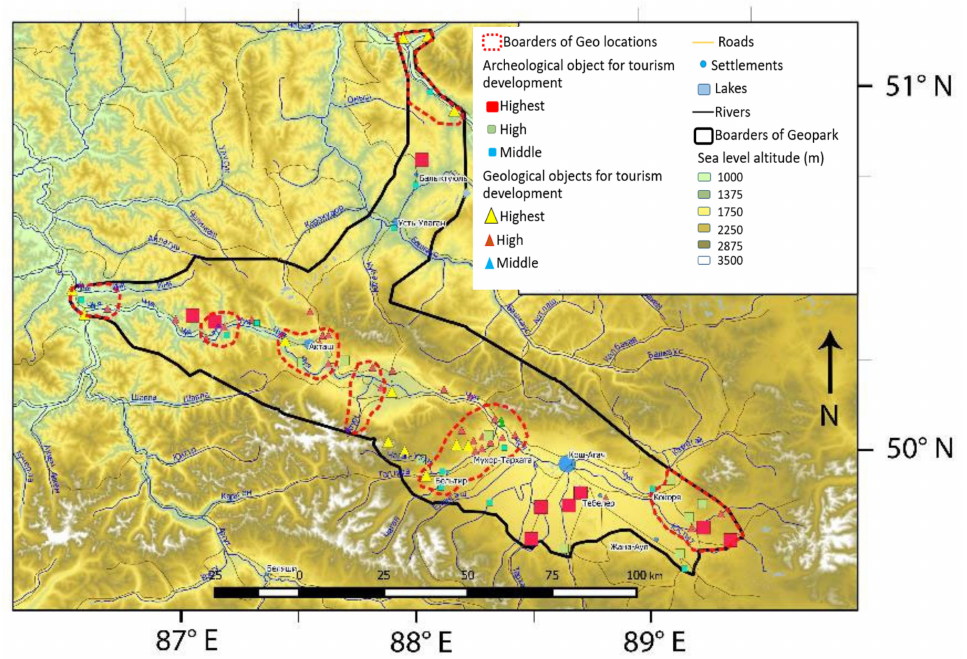
Figure 4. Entire territory of Geopark